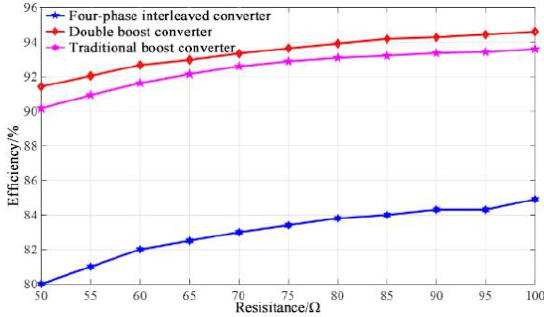
Figure 20. Efficiency comparison under different loads.